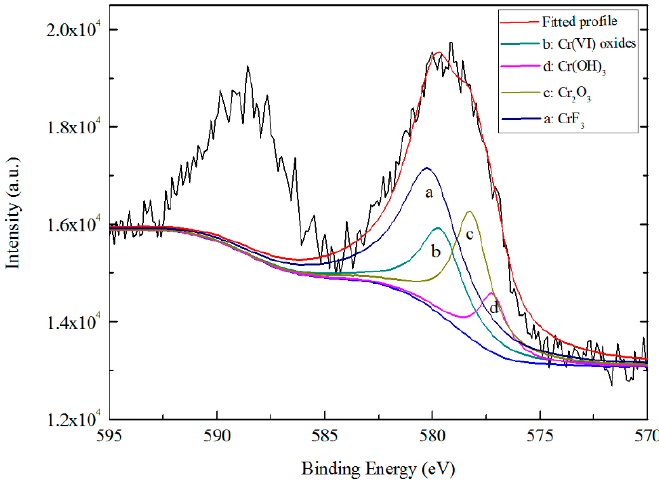
Figure 13. High resolution XPS spectrum and curve fitting for Cr 2 p photoelectron region for a TCC formed on Zn55Al for 180 s in TCP bath at 40 ° C.